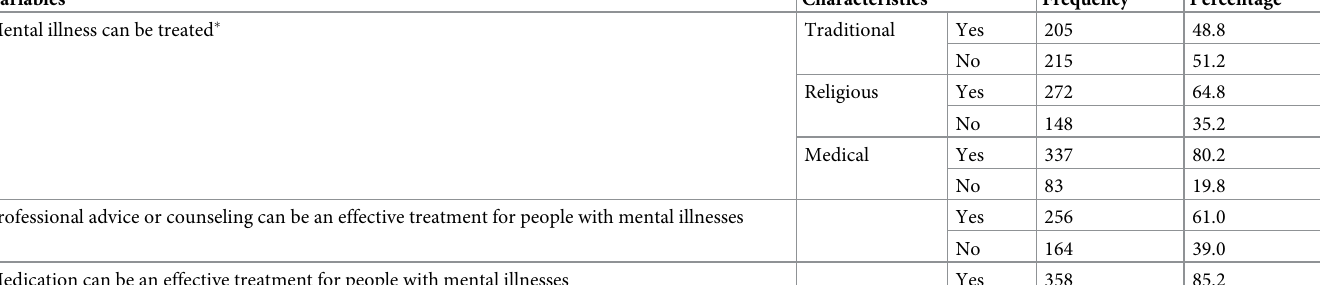
Table 4. Treatment preference of the respondents towards mental health and mental health problems at Jimma Zone, Seka Chekorsa district, Oromia, Ethiopia, March 2020.